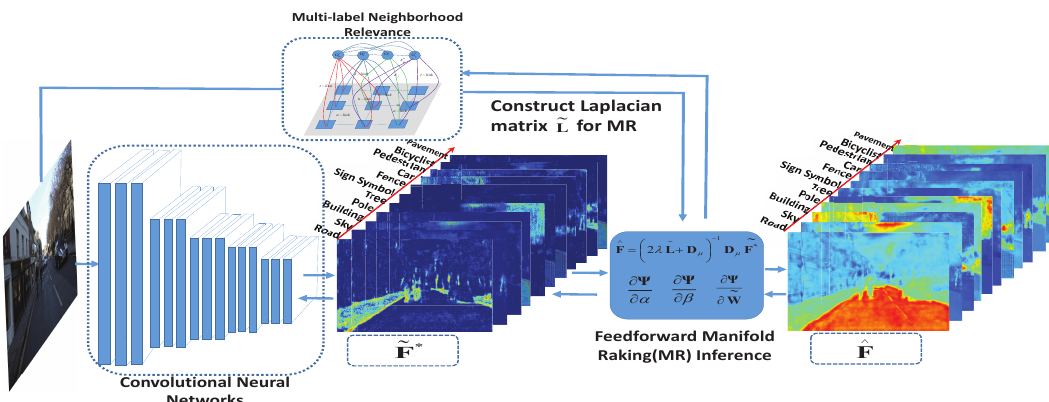
Figure 2. The embedded feedforward single stream manifold ranking optimization network. The output of the convolutional features that upsample to full image resolution for each class, such as road, sky and building, within the CamVid dataset [68,69] depicted in the figure, serves as the initial ∗ manifold ranking score (cid:101) F to be optimized. By applying the feedforward MR inference with the contextual information extracted from the input image, the optimal MR score (cid:98) F of each class can be obtained by Equation (10). The only requirement for the proposed network is the multi-label neighborhood relationship, which is designed for constructing the Laplacian matrix (cid:101) L in a single stream rather than the unary and pairwise streams presented in